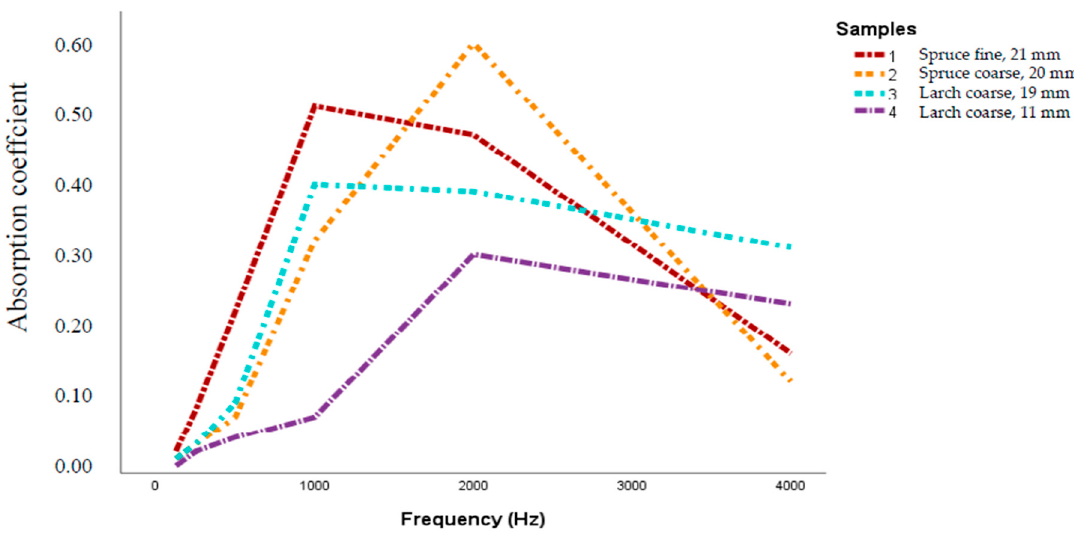
Figure 2. Sound absorption coefficient for spruce and larch bark insulation boards, measured without wall wall clearance.